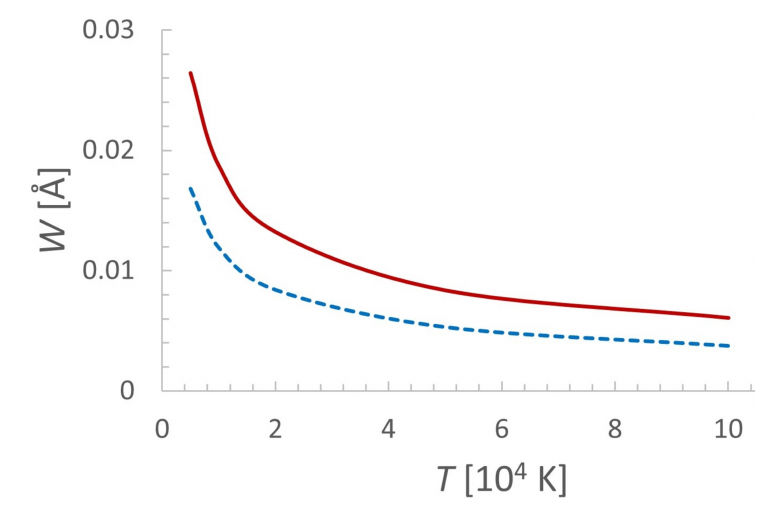
Figure 1. The behavior of Stark widths with temperature for Zn III 4p 1 P o –4d 1 S, λ = 1203.3 Å (red solid line) and 4p 3 P o –4d 3 S, λ = 1326.9 Å (blue dashed line) spectral